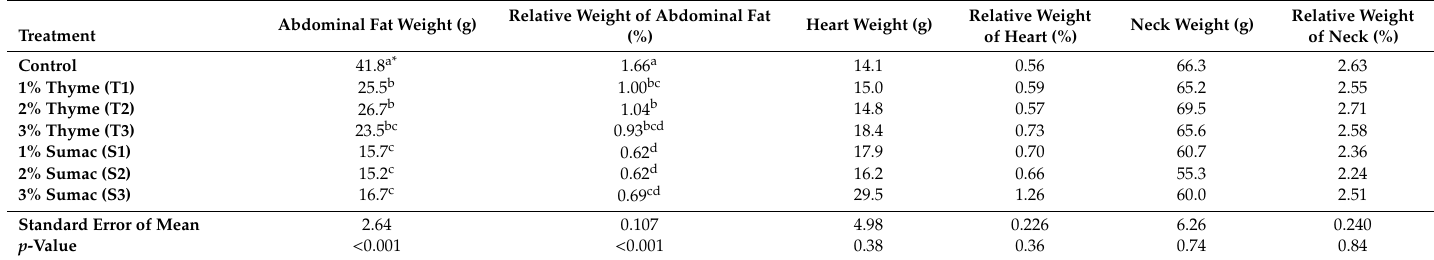
Table 4. Abdominal fat, heart, and neck actual and relative weights at 42 days of age in Ross 308 broilers fed diets containing 0, 1, 2, and 3% thyme (T3) and sumac from days 29–42.